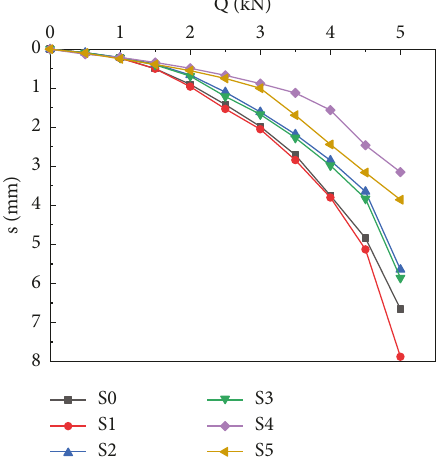
Figure 15: Q-s curves.